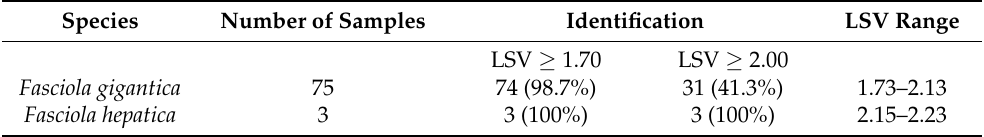
Table 1. Identification of 78 adult Fasciola spp. samples obtained from Nigeria and Switzerland by MALDI-TOF MS, using a newly developed in-house database. LSV, log-score value.